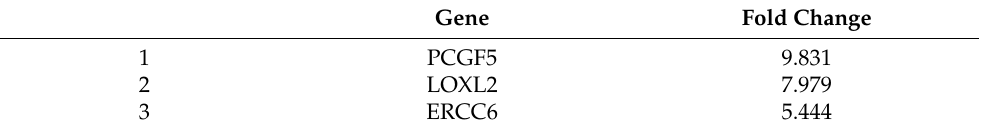
Table 9. Genes in epigenetic category that are upregulated in endothelial cells. Gene Fold Change